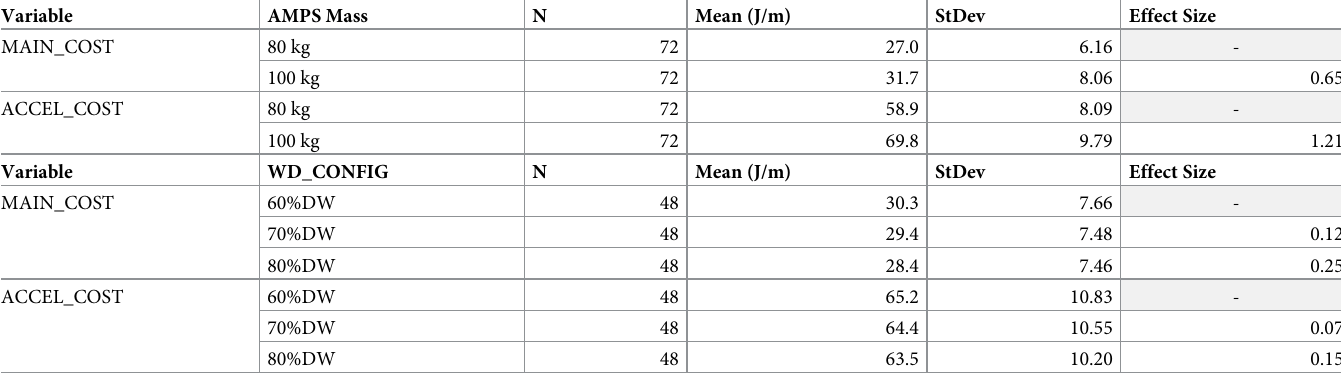
Differences in cost associated with mass and weight distribution Basic statistics of the propulsion cost for each maneuver were grouped by system mass and by weight distribution. The propulsion costs were averaged across the different wheel configura- tions and surfaces. Costs of propulsion varied across mass and weight distribution in a consis- tent manner across the three canonical maneuvers. For the straight trajectory maneuver, the increase from 80 kg to 100 kg had a medium effect on the main cost and a very large effect on the acceleration cost ( Table 8 ). The weight distribution had a small effect size for both acceler- ation and main costs. For the fixed-wheel turn maneuver, the effect size of increased mass was large on the main propulsion cost and very large during the acceleration phase ( Table 9 ). The effect of weight Table 8. Straight trajectory: Cost